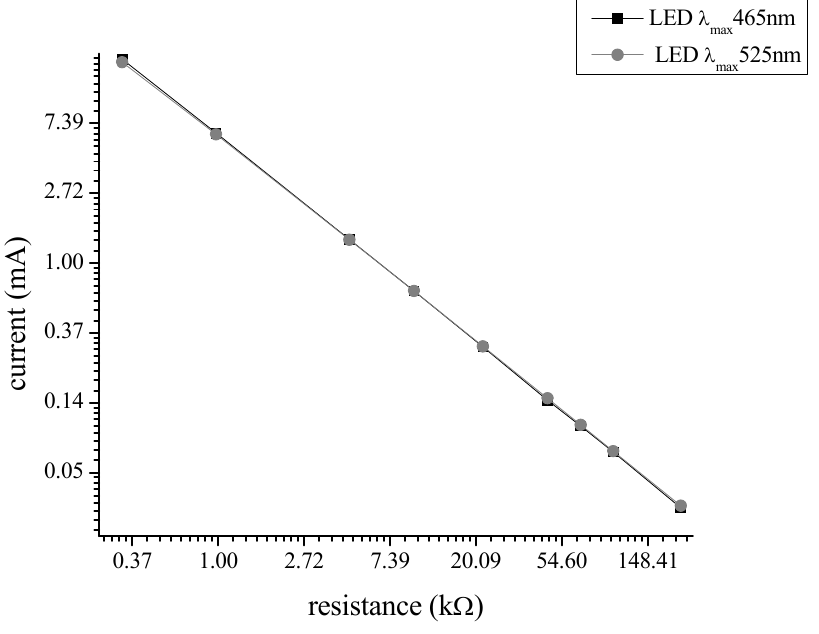
Figure 9. Determination of current: Different resistors between 330 Ω and 220 k Ω were connected with the LED in series. For experiments a 9 V voltage supply was used. The voltage drop at the resistor was measured and the resulting current